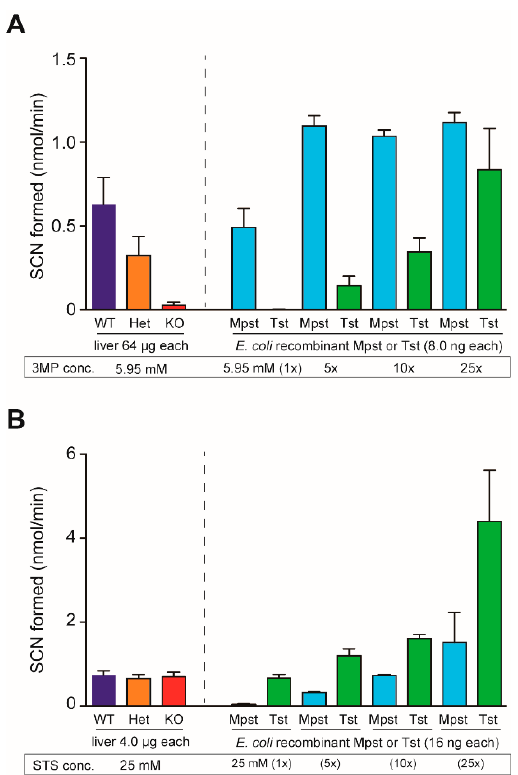
Figure 3. Mpst and Tst (rhodanese) enzyme activities from wild-type (WT), heterozygous (Het),